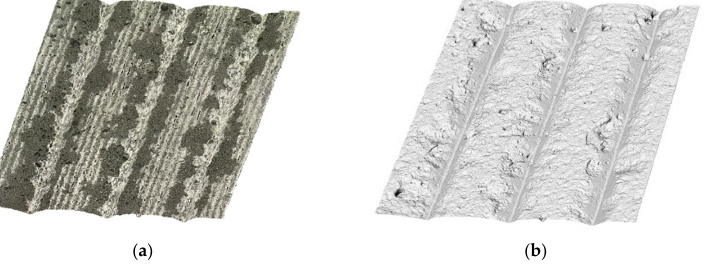
Figure 14. 3D scanning with Calibry mini: ( a ) surface of the rock after cutting and ( b ) mesh obtained via 3D scanning.